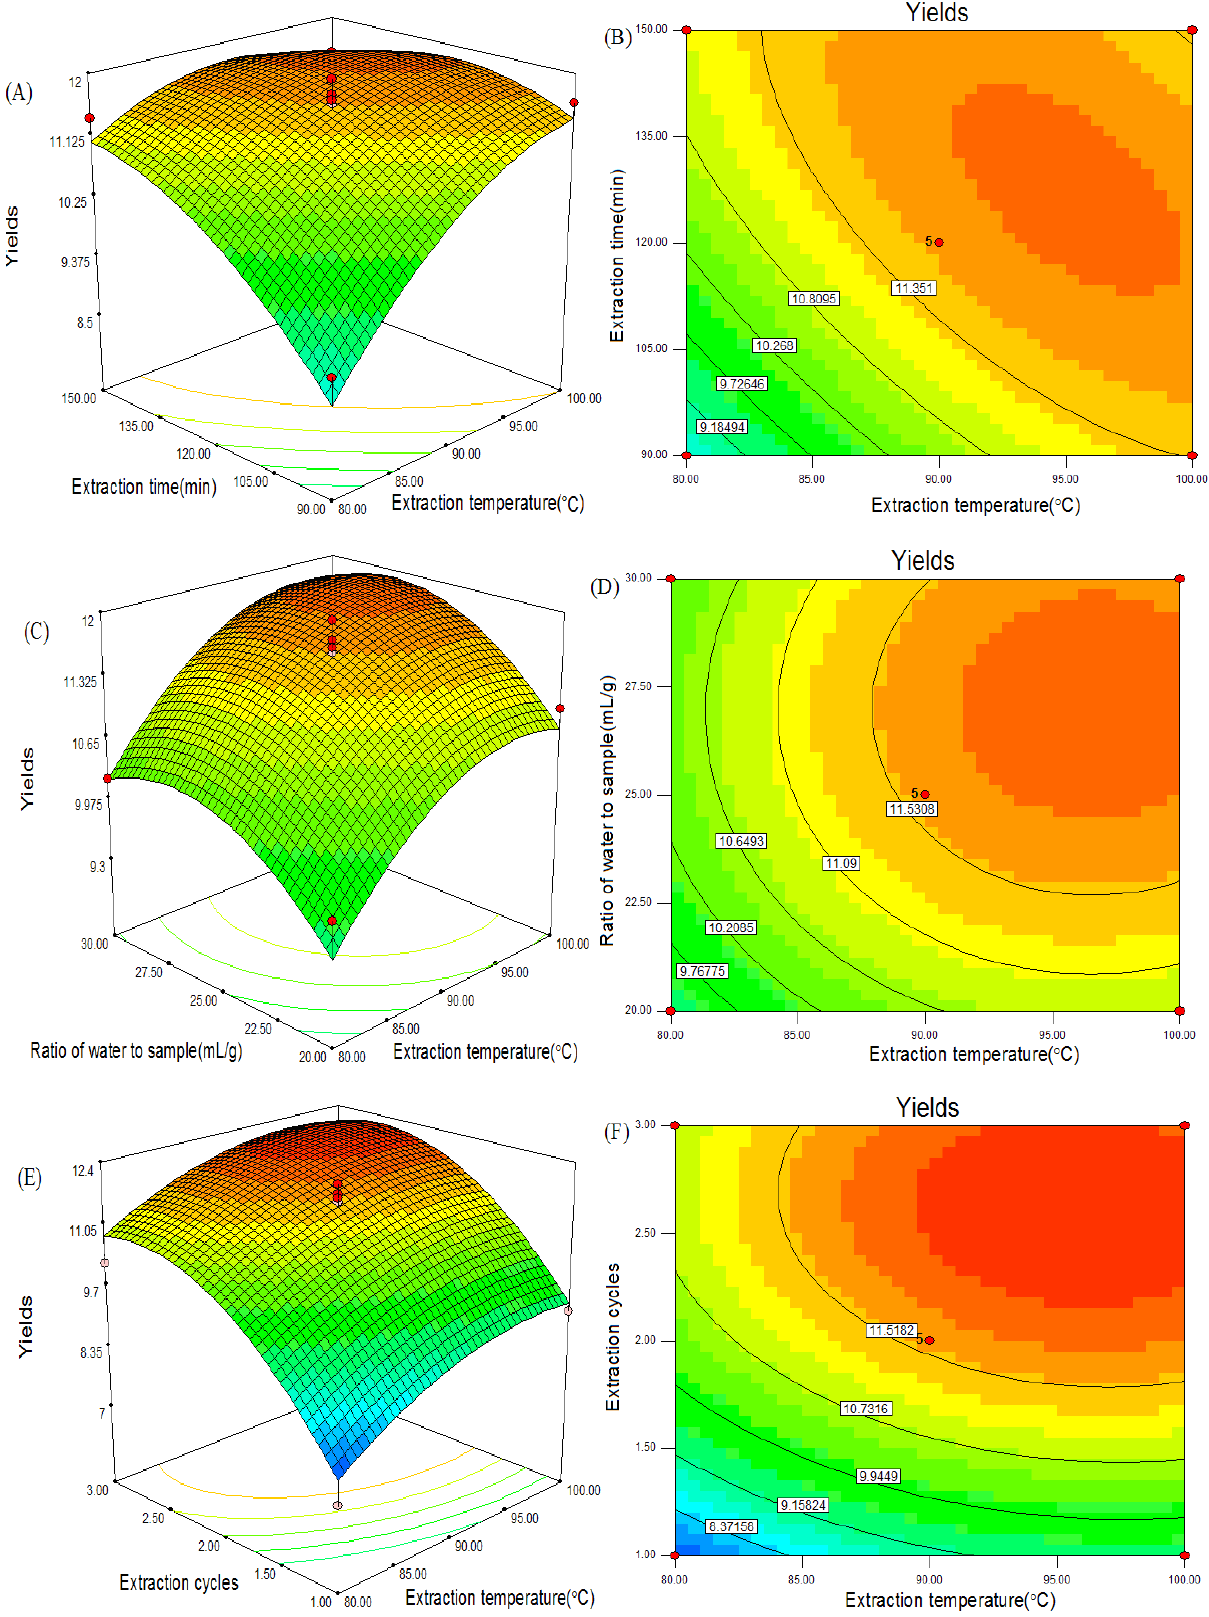
Figure 5. Response surface plots (3-D) and contour plots (2-D) showing the effects of variables (X : extraction temperature; X 1 X : extraction 4